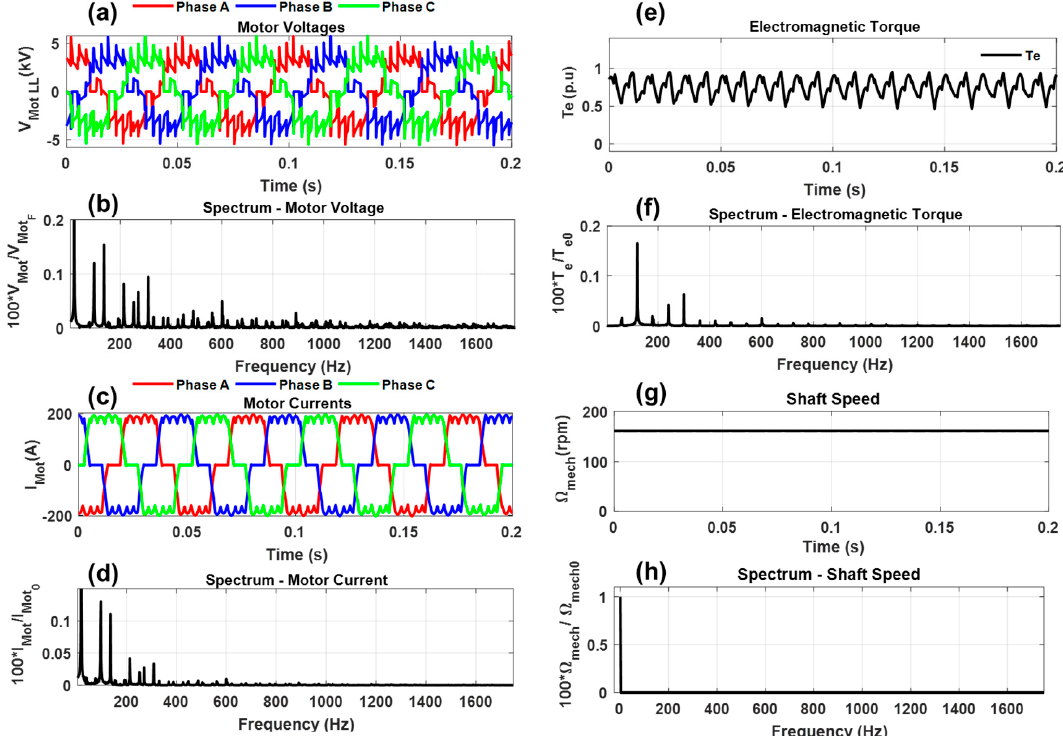
Figure 15. Sample simulation results of a 6/6-pulse LCI system at 40 Hz: ( a ) motor voltages, ( b ) spectrum of motor voltage, ( c ) motor currents, ( d ) spectrum of motor current, ( e ) motor electromagnetic torque, ( f ) spectrum of motor electromagnetic torque, ( g ) shaft speed and ( h ) spectrum of shaft speed.